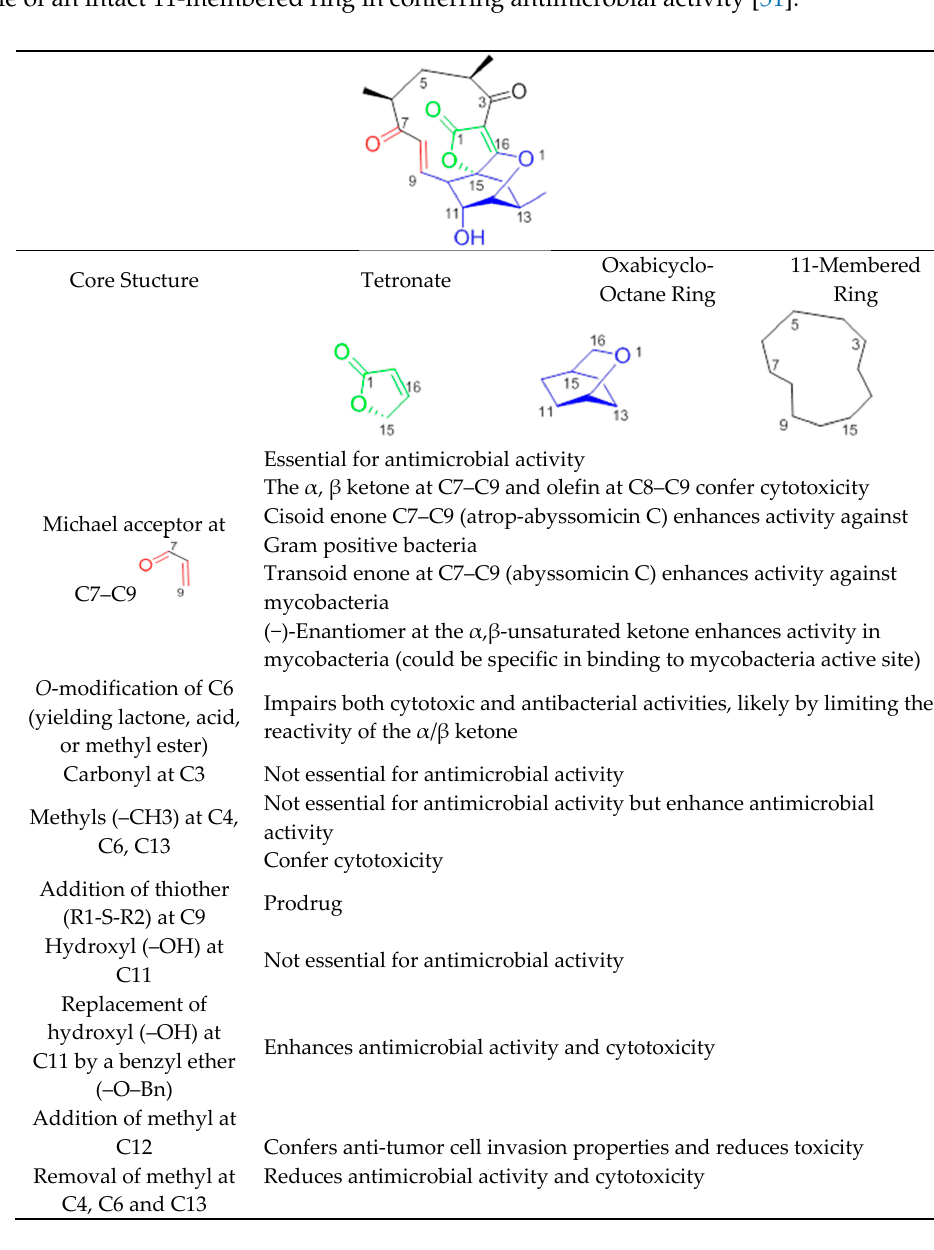
Figure 11. Structure–activity relationship of abyssomicins conferring antimicrobial activity against Gram-positive bacteria and mycobacteria.